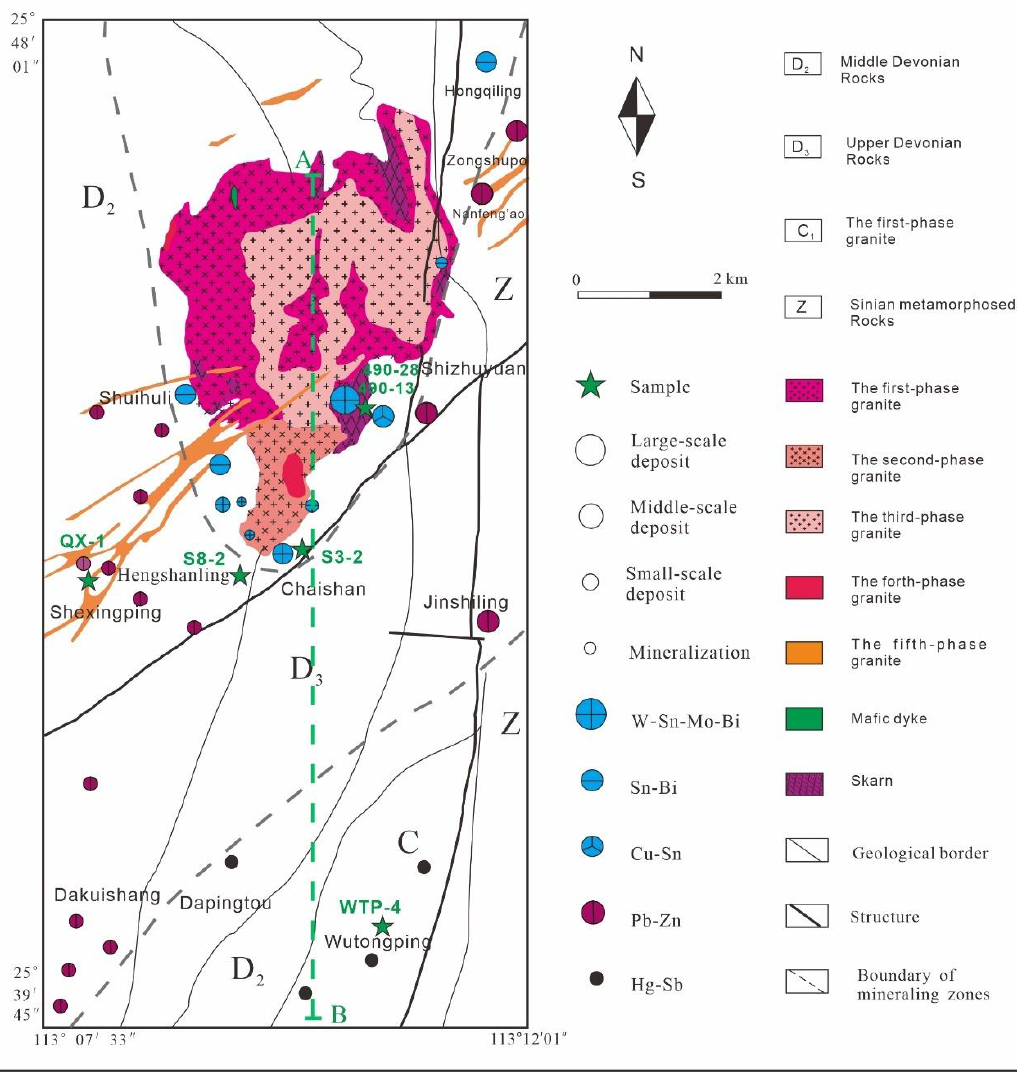
Figure 3. Mineralizing zones in the Shizhuyuan ore-field. Inner zone: W-Sn-Mo-Bi; Middle zone: Pb-Zn; and Outer zone: Hg-Sb (modified after [14]).